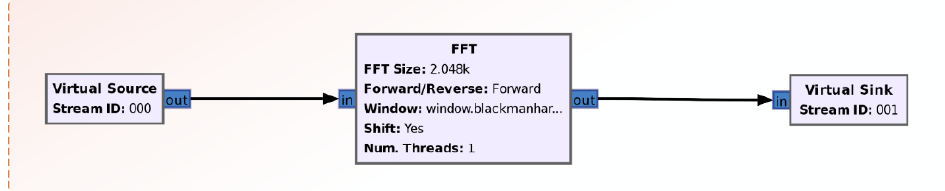
Figure 4. FFT calculation method in GNU Radio.